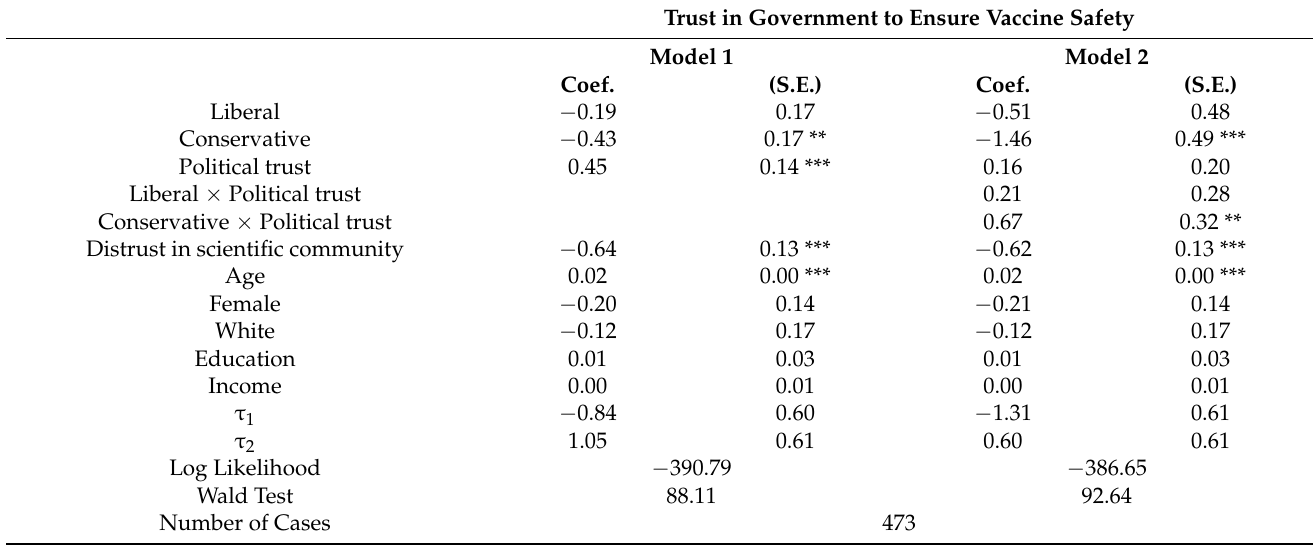
Table 3. Regression